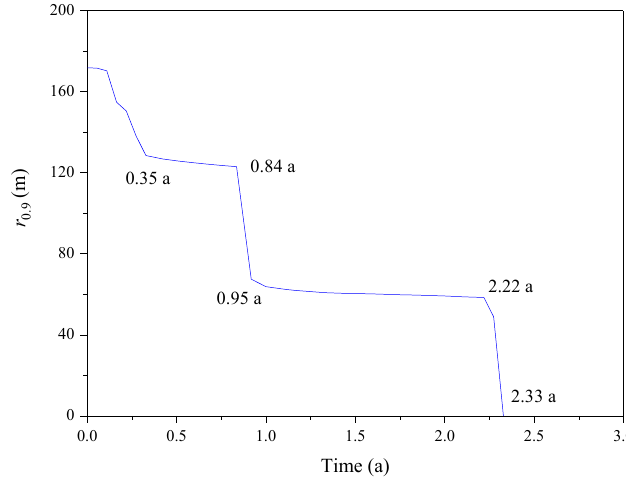
Figure 10. The relationship of r 0.9 with time for the UGSR with 20% CO 2 as cushion gas.